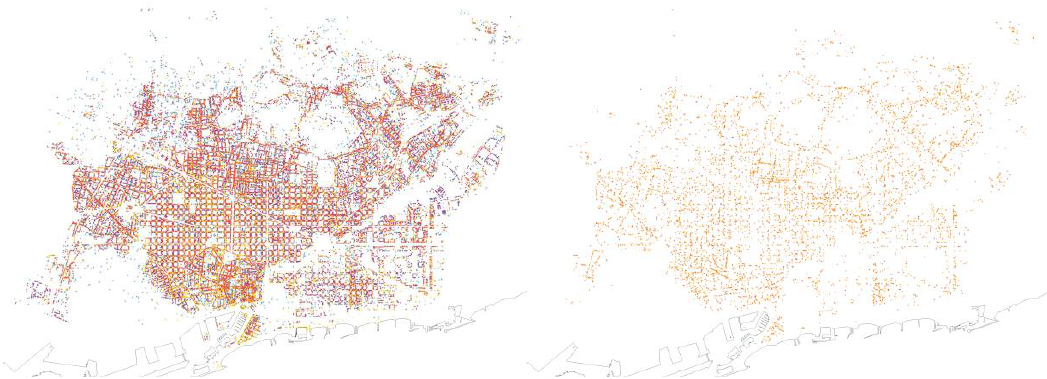
Figure 1. On the left, activities at street level in Barcelona (food suppliers in orange, retail in red, facilities in blue, hospitality in yellow and other services in purple). On the right, the essential services analyzed in this article (representing with the same color markets, supermarkets, grocery stores, bakeries, healthcare facilities and pharmacies).